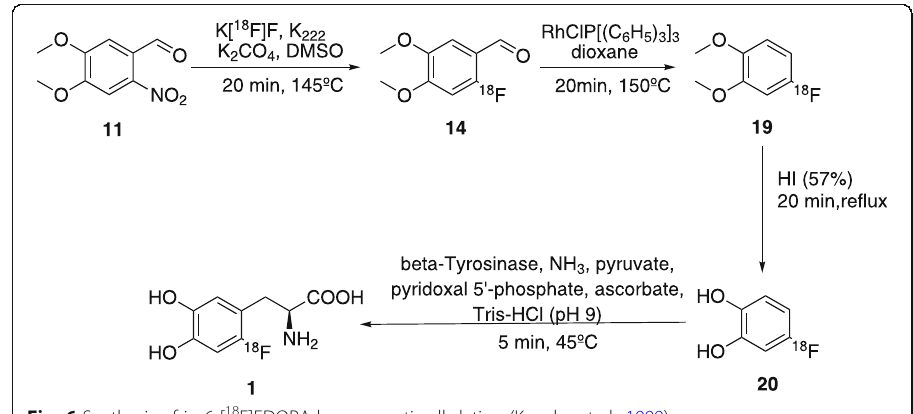
Fig. 6 Synthesis of in 6-[ 18 F]FDOPA by enzymatic alkylation (Kaneko et al.,